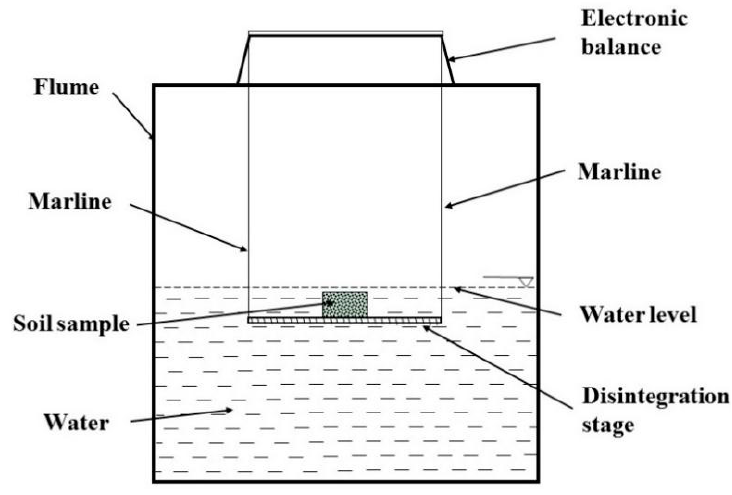
Figure 3. Schematic diagram of soil disintegration equipment.